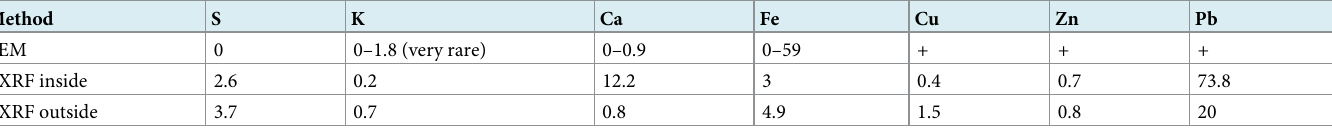
Mean values and ranges in wt%, traces are marked with: + (for discussion see text).